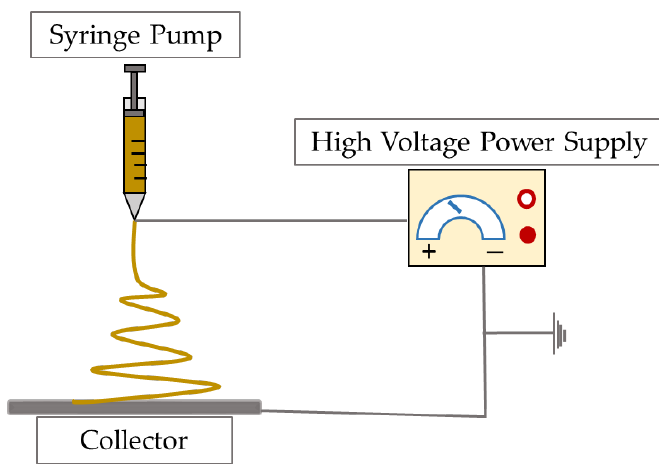
Figure 3. Schematic illustration of the electrospinning set-up.